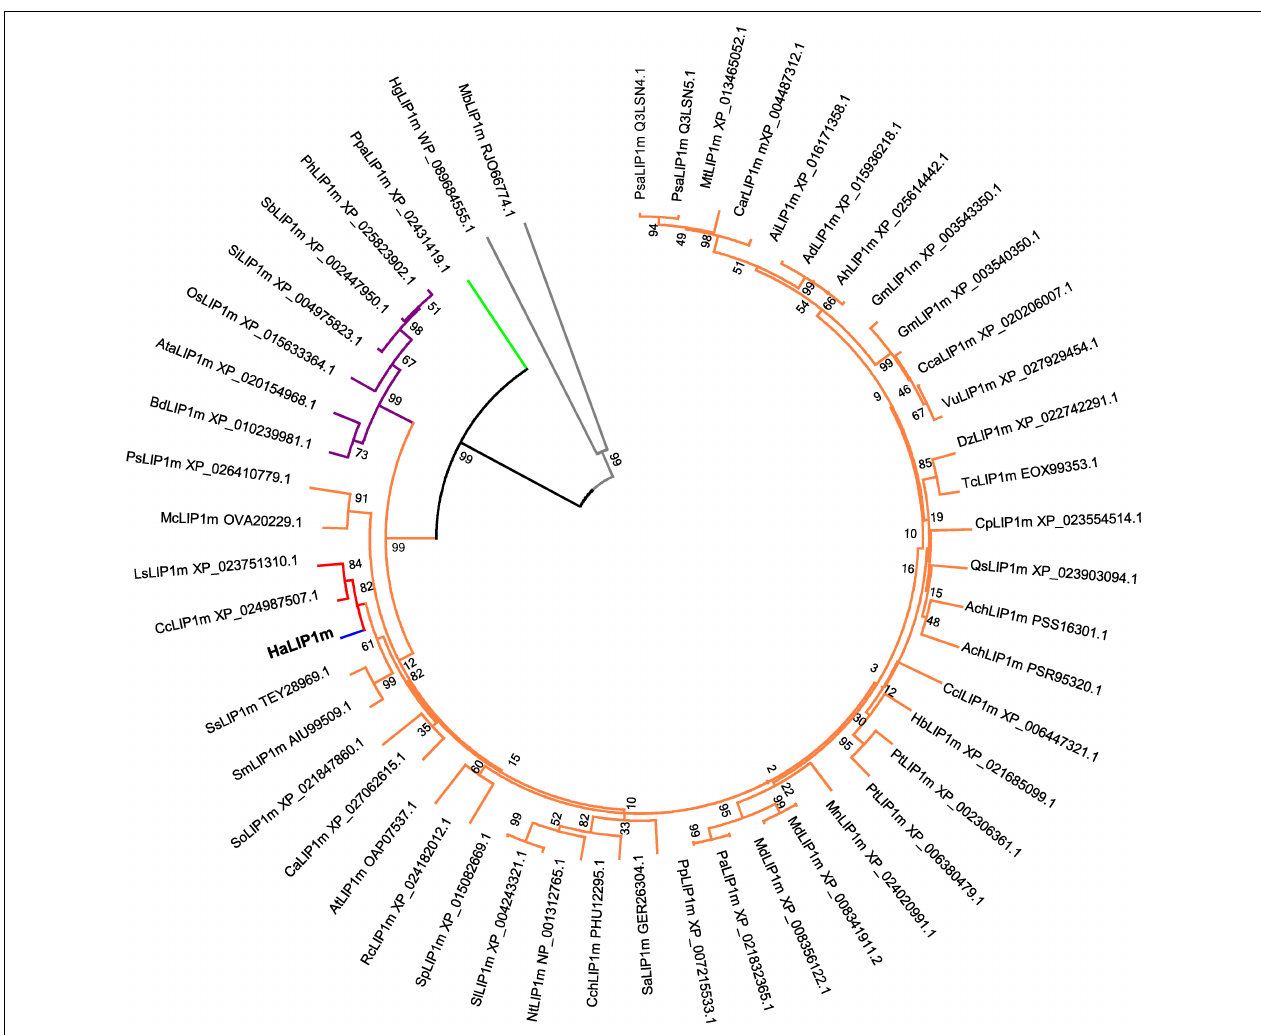
FIGURE 1 | Phylogenetic tree of annotated mitochondrial lipoyl synthases. The plant species included in the tree are: Ach, Actinidia chinensis; Ad, Arachis duranensis; Ah, Arachis hypogaea; Ai, Arachis ipaensis; At, Arabidopsis thaliana; Ata, Aegilops tauschii; Bd, Brachypodium distachyon; Ca, Coffea Arabica; Car, Cicer arietinum; Cc, Cynara cardunculus; Cca, Cajanus cajan; Cch, Capsicum chinense; Ccl, Citrus clementine; Cp, Cucurbita pepo; Dz, Durio zibethinus; Gm, Glycine max; Hb, Hevea brasiliensis; Ls, Lactuca sativa; Mc, Macleaya cordata; Md, Malus domestica; Mn, Morus notabilis; Mt, Medicago truncatula; Nt, Nicotiana tabacum; Os, Oryza sativa; Pa, Prunus avium; Ph, Panicum hallii; Pp, Prunus persica; Ps, Papaver somniferum; Psa, Pisum sativum; Pt, Populus trichocarpa; Qs, Quercus suber; Rc, Rosa chinensis; Sa, Striga asiatica; Sb, Sorghum bicolor; Si, Setaria italic; Sl, Solanum lycopersicum; Sm, Salvia miltiorrhiza; So, Spinacia oleracea; Sp, Solanum pennellii; Ss, Salvia splendens;Tc, Theobroma cacao;Vu, Vigna unguiculata. LIP1m from a bryophyte species ( Ppa . Physcomitrella patens) was used as the outgroup (green subtree). Ha LIP1m is marked in blue, the Asteraceae family in red, the Dicotyledoneae group in orange, Monocotyledoneae species in purple and two Proteobacteria species in gray ( Hg, Halomonas gudaonensis and Mb, Myxococcales bacterium